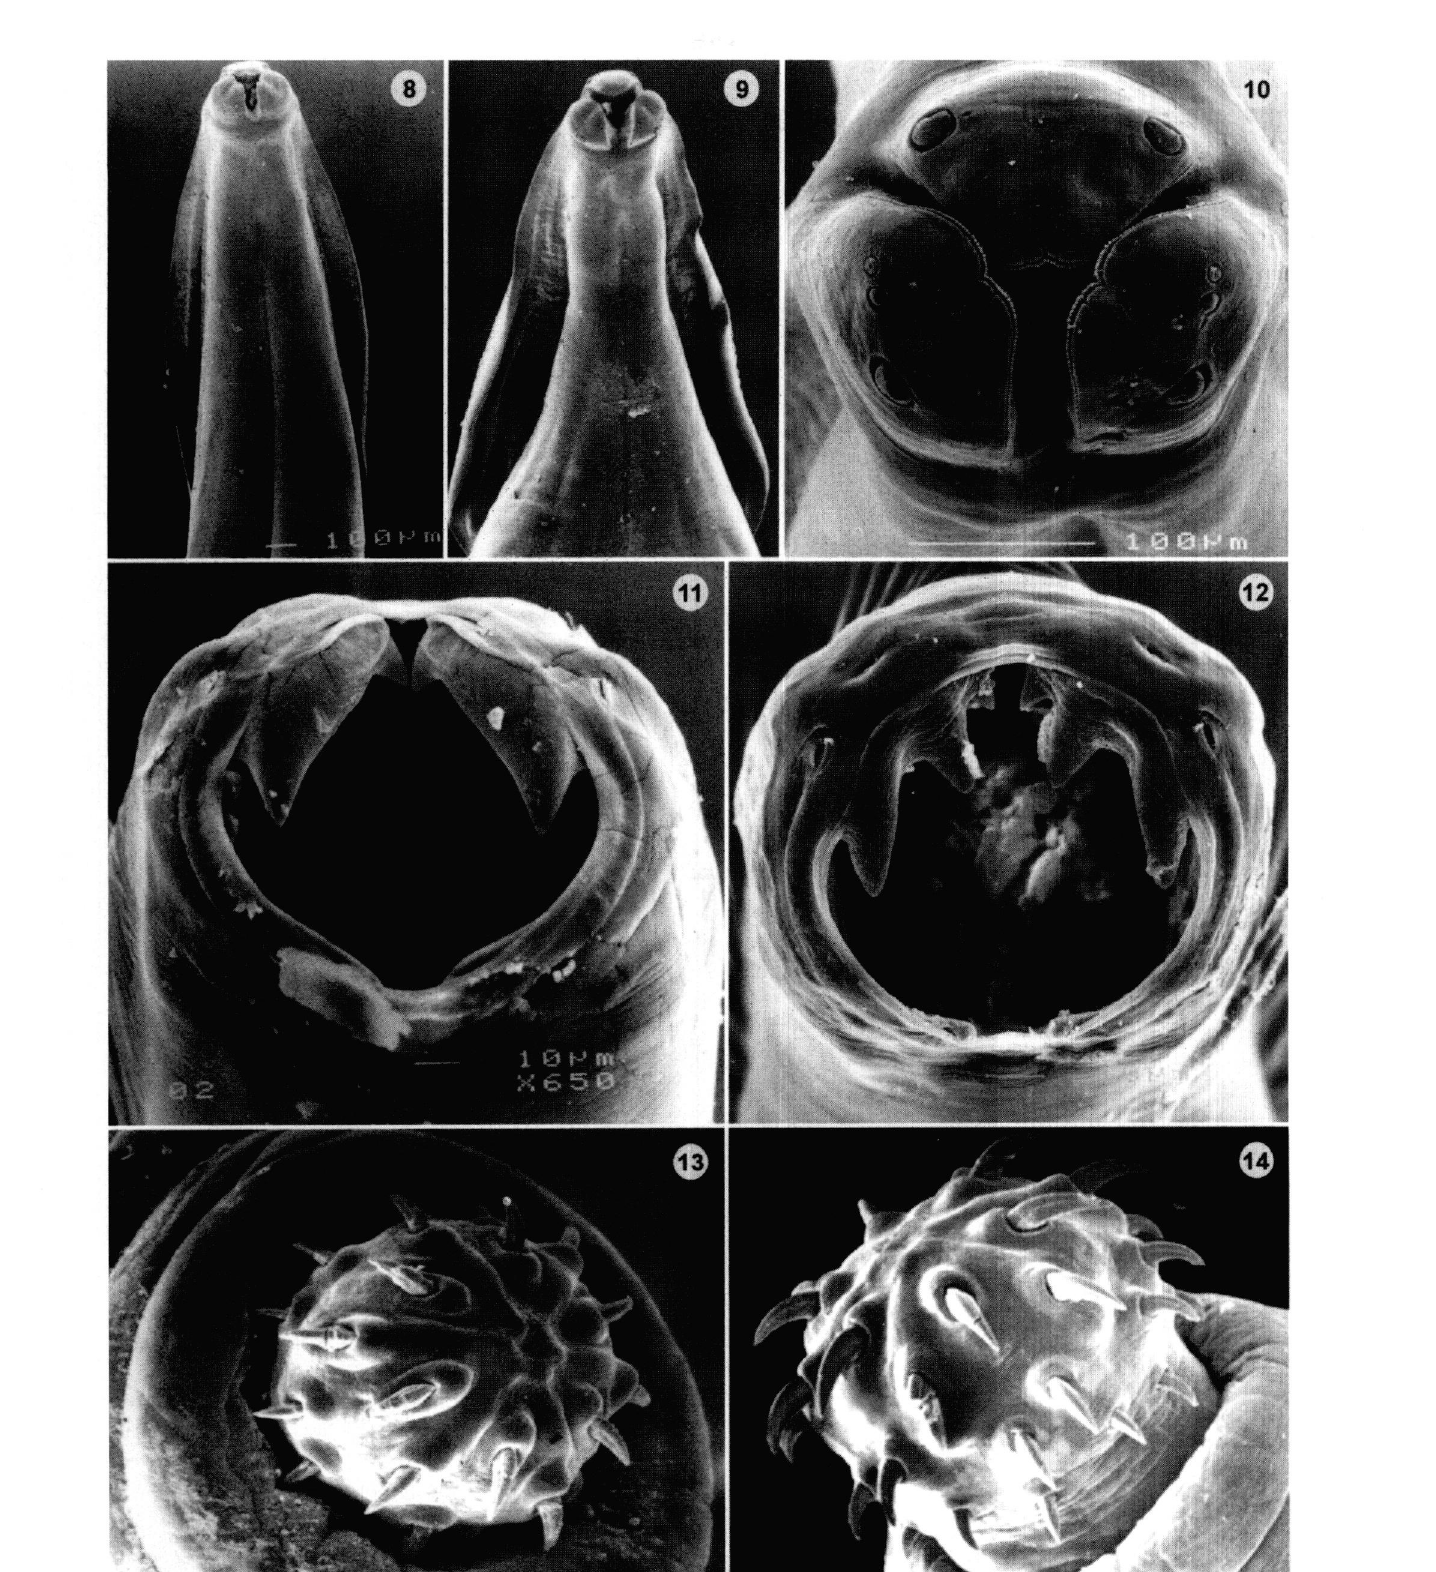
Fig. 8. - Toxocara canis. Anterior end with cervical alae; ventral view. Figs 9-10. - Toxocara cati. 9. Anterior end with cervical alae; ventral view. 10. Circumoral lips; apical view. Fig. 11. - Ancylostoma ceylanicum. Mouth cavity with two pairs of articular teeth; sub- apical view. Fig. 12. - Ancylostoma tubaeforme. Mouth cavity with three pais of cuticular teeth; subapical view. Figs 13-14. - Oncicola sp. Proboscis; subapical views (SEM photomicrographs).